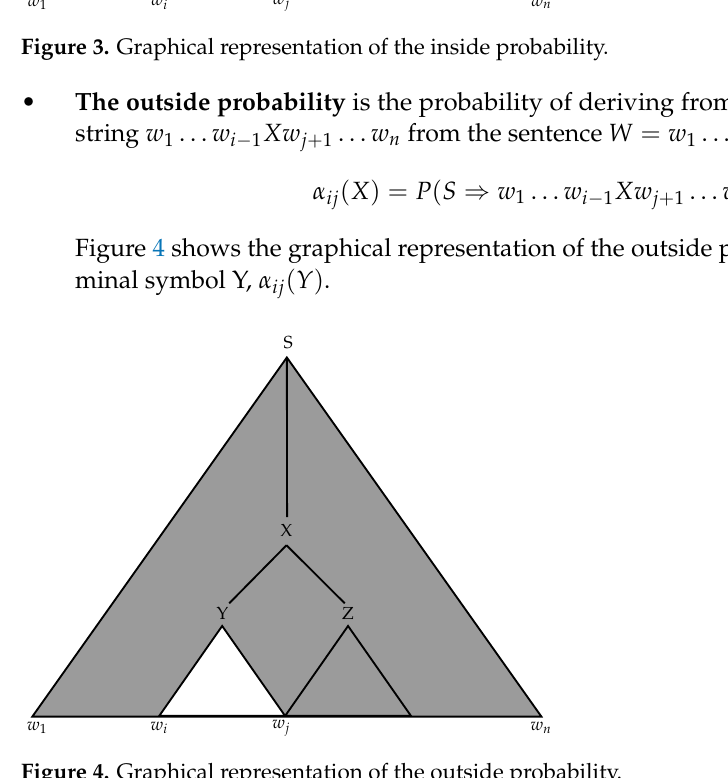
Figure 4. Graphical representation of the outside